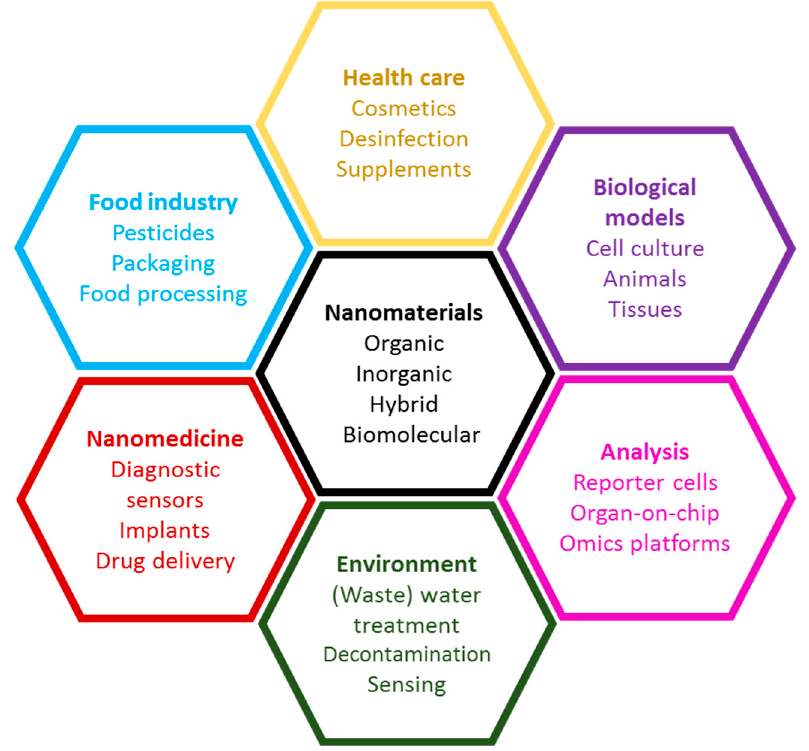
Figure 1. Interactions of nanomaterials with biological systems.